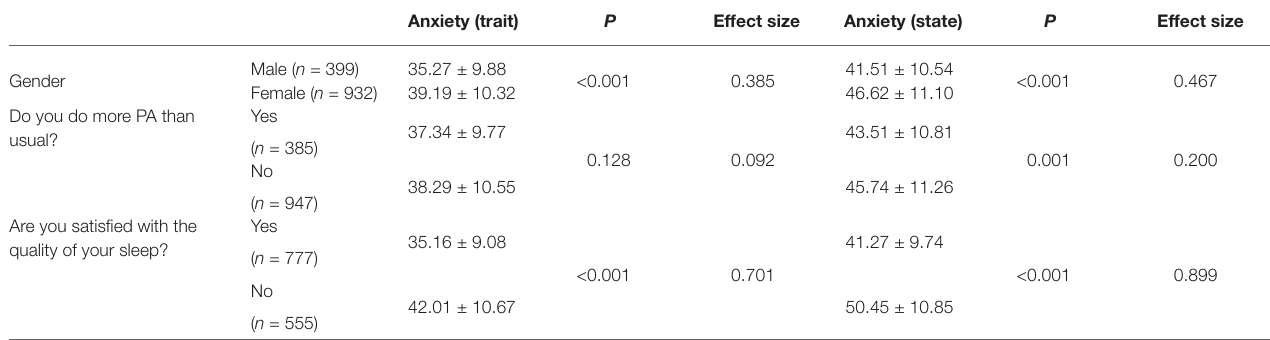
TABLE 2 | Variation in state anxiety and trait anxiety associated with gender, PA, and quality of sleep. Anxiety (trait)